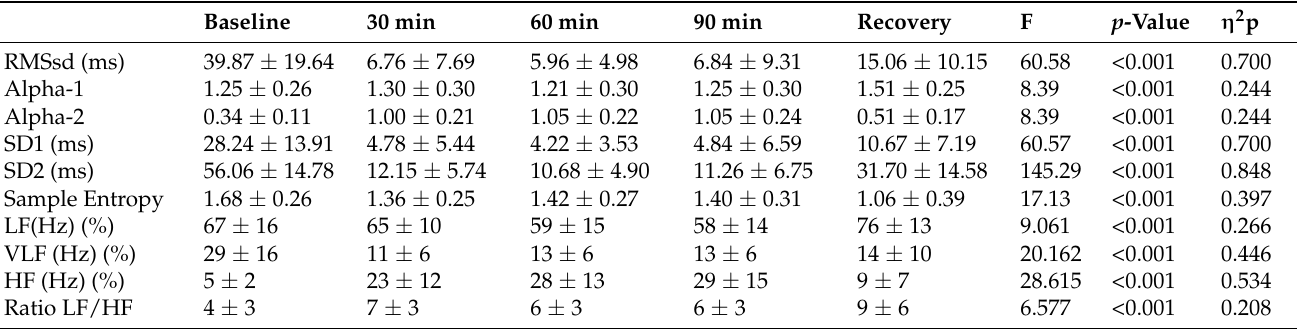
Table 2. Descriptive (mean ± standard deviation) and inferential analysis of HRV during an amateur padel